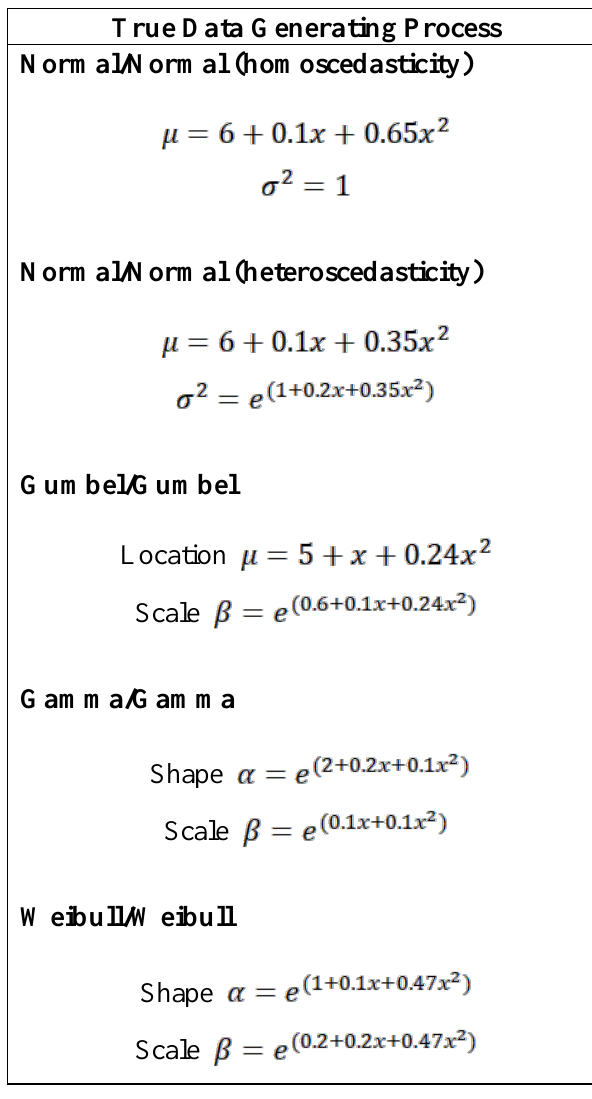
Table A1. Simulation process: conditional distribution of the data for the test of incorrect distributional family.